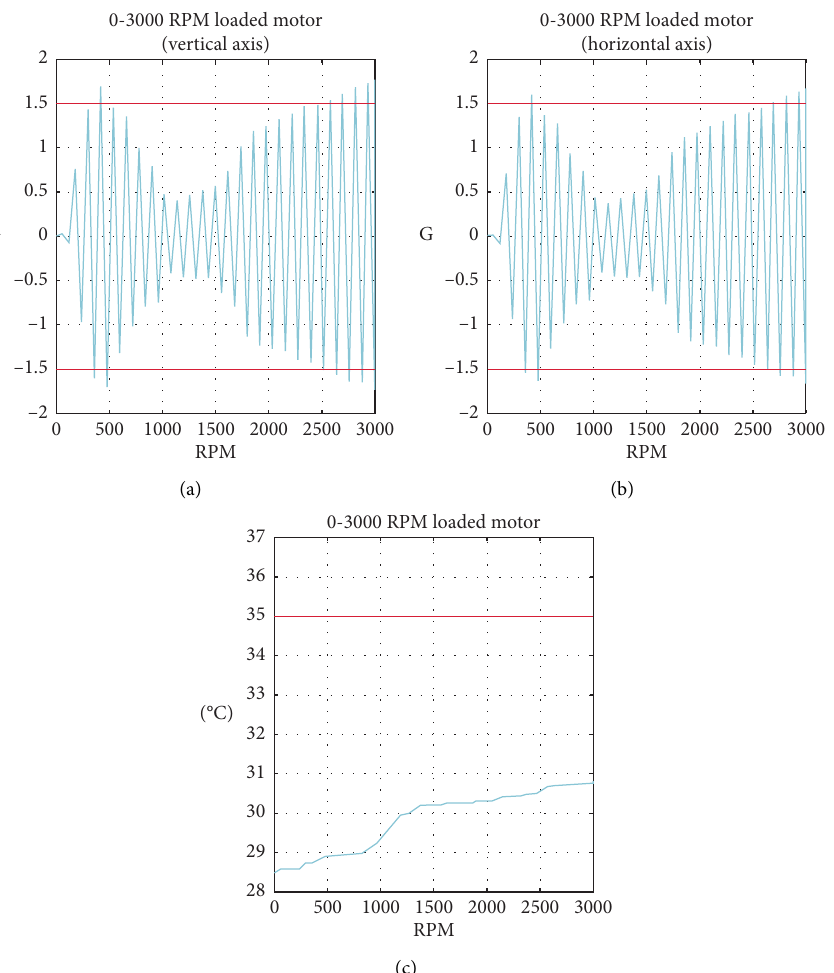
Figure 7: The 0–3000 RPM measurement-speed graph of the loaded motor: (a) vertical axis, (b) horizontal axis, and (c) temperature-speed graph of the loaded